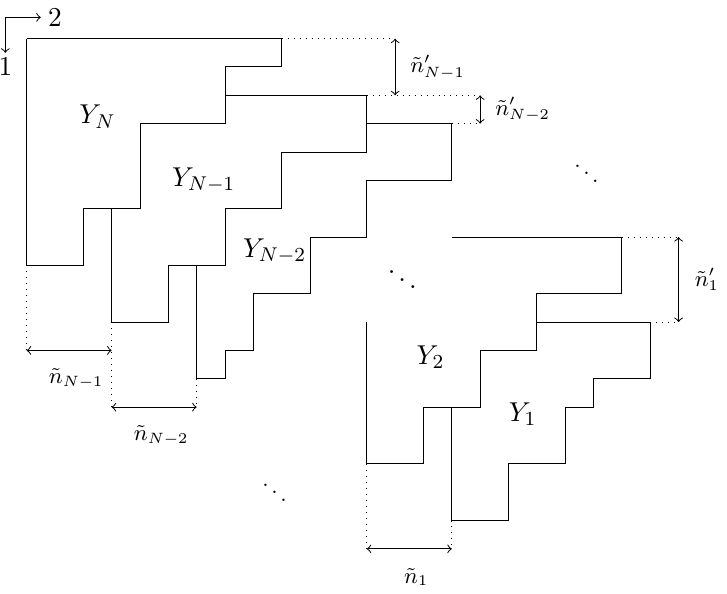
Figure 6 . The Young diagrams associated with minimal model of W N (and U(1)) can be interpreted as plane partition by stacking them as shown in the above